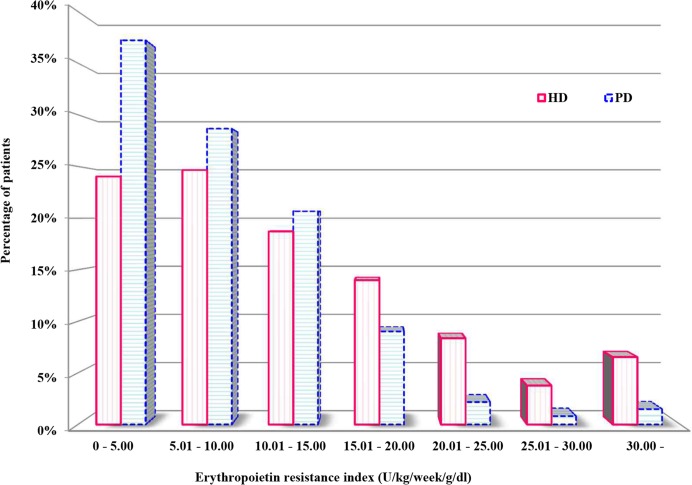
Distribution of patients according to erythropoietin resistance index in hemodialysis and peritoneal dialysis patients.